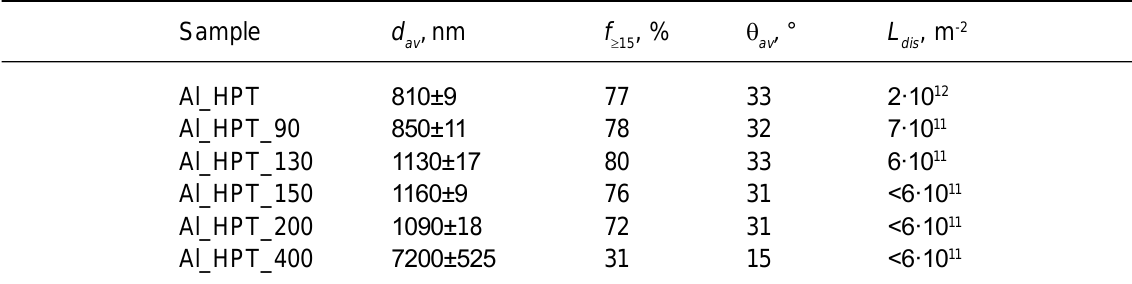
Table 1. The parameters of the microstructure of Al samples after HPT processing and subsequent anneal- ing [12,13]: d is the average grain size, f is the percentage of GBs with the misorientation angle  15°,  av  15 is the average angle of GB misorientations, and L is the dislocation dis